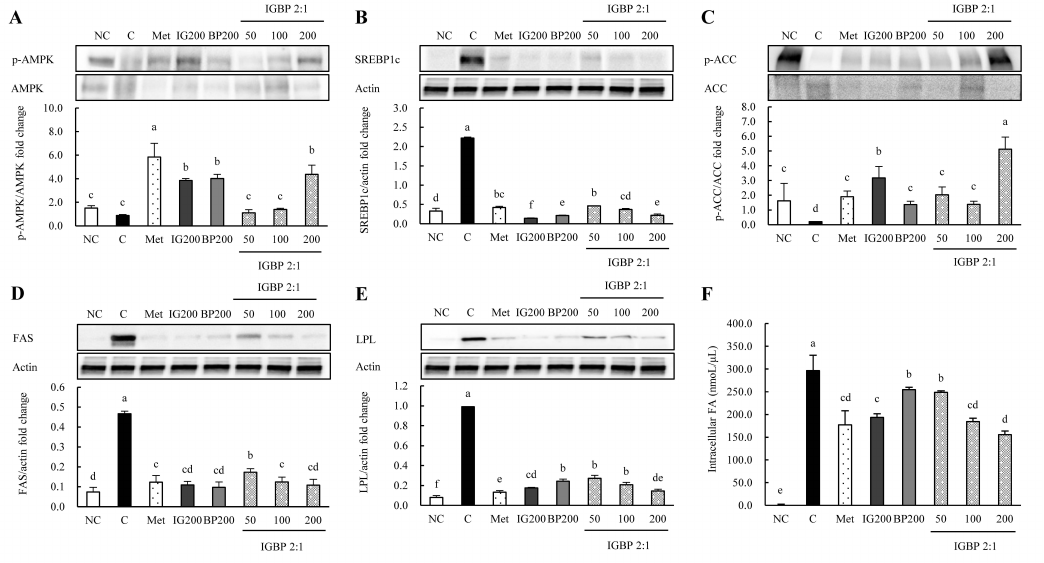
Figure 4. E ff ects of the IGBP 2:1 mixture on lipogenesis-related proteins and fatty acid (FA) levels in 3T3-L1 adipocytes: ( A ) p-AMPK / AMPK expression ratio, ( B ) SREBP1c expression, ( C ) p-ACC / ACC expression ratio, ( D ) FAS expression, ( E ) LPL expression, and ( F ) intracellular FA levels. NC, normal control; C, di ff erentiated control; Met, metformin 1 mM; IG200, IG 200 µ g / mL; BP200, BP 200 µ g / mL; IGBP 2:1 (50, 100, or 200 µ g / mL). The resulting values are shown as mean ± standard deviation (SD; n = 3), and the di ff erent superscript letters (alphabet) indicate significance at p <